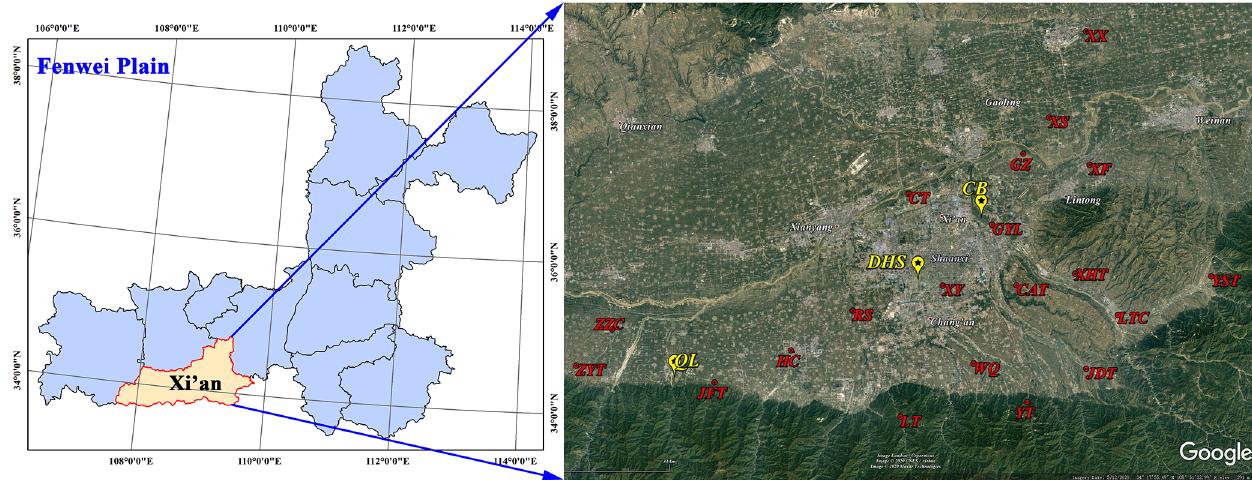
Figure 1. VOC field observation and grid sampling sites in Xi’an (© Google Earth). The topographic image was obtained from Google Earth.